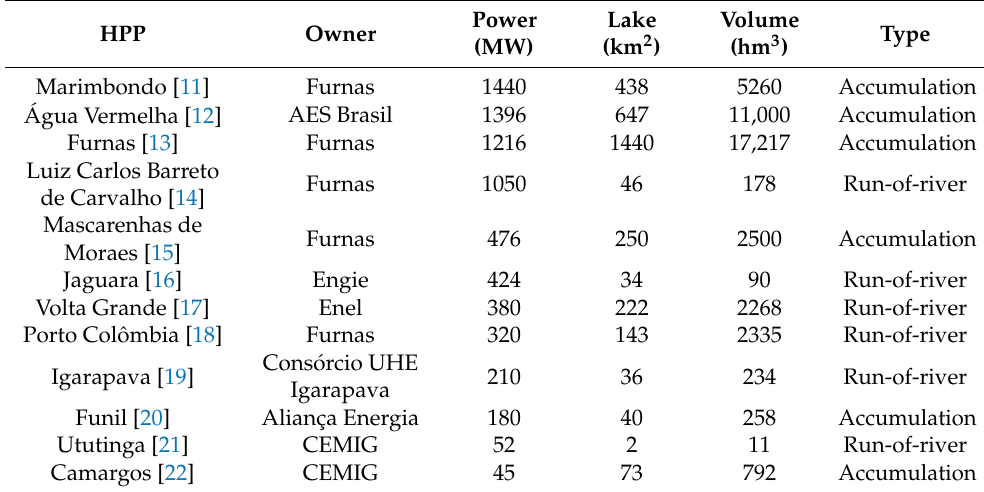
Table 1. Hydroelectric Power Plants Implemented in Rio Grande, Brazil.